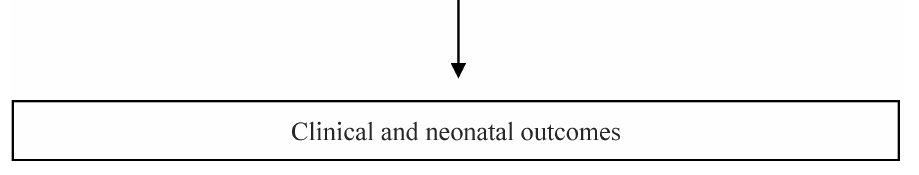
Fig 1. Flowchart of study